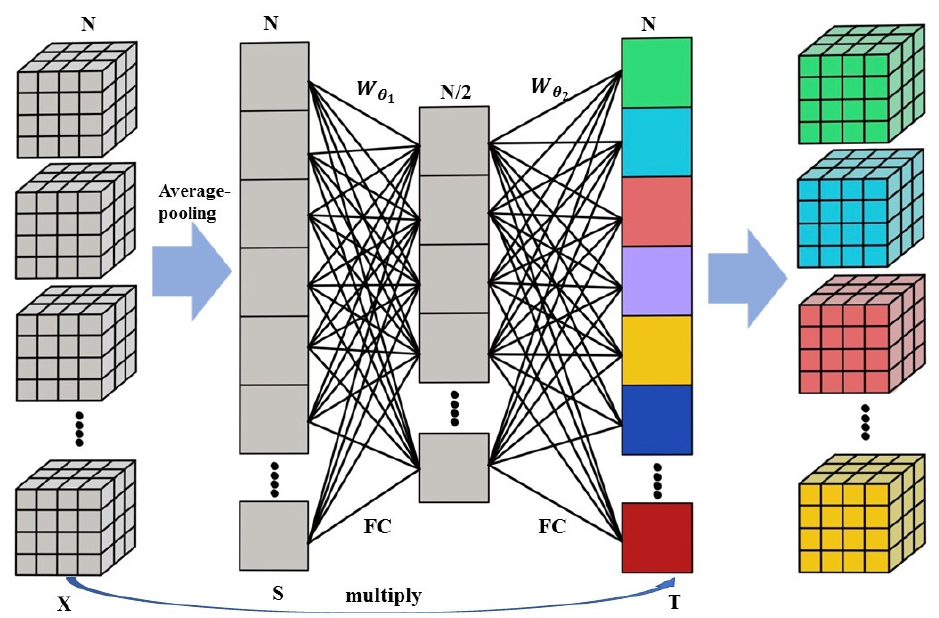
Figure 2. The Architecture of the Employed Attention Strategy. In general, the feature attention mechanism we proposed includes one average-pooling layers, two thin fully connected networks (FC layers), and a multiply operation of the scaling coefficient and the input tensor.